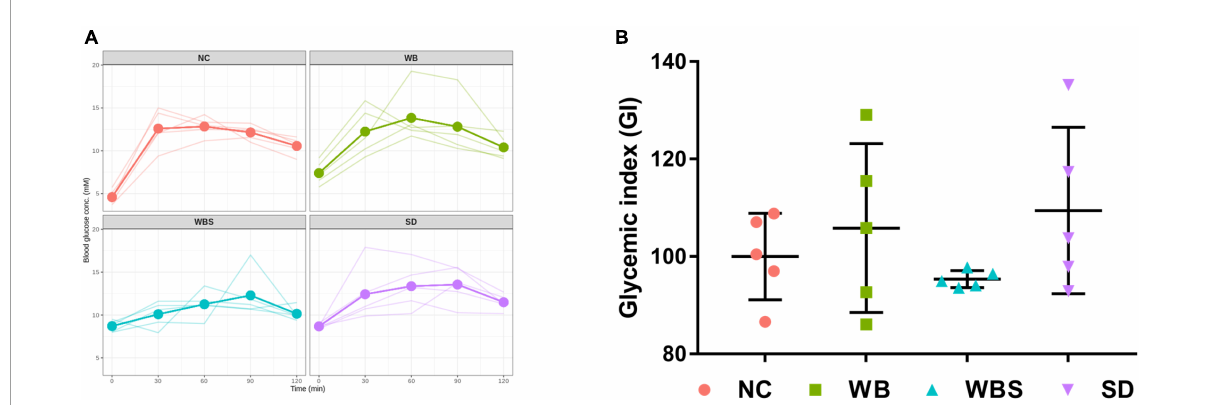
FIGURE2 Change in blood glucose concentration and glycemic index (GI) in all groups. (A) Line graph of blood glucose concentration of individual mouse in all groups up to 2 h. Bold line presents the average value of five replicates ( n = 5 male mice) in each group. (B) GI dot plot with error bar of five replicates ( n = 5 male mice) in each group. NC: normal diet group as negative control, WB: mouse feeding group with yeast-fermented white bread, WBS: mouse feeding group with 40% sourdough-supplemented white bread, SD: mouse feeding group with 100% unbaked sourdough.